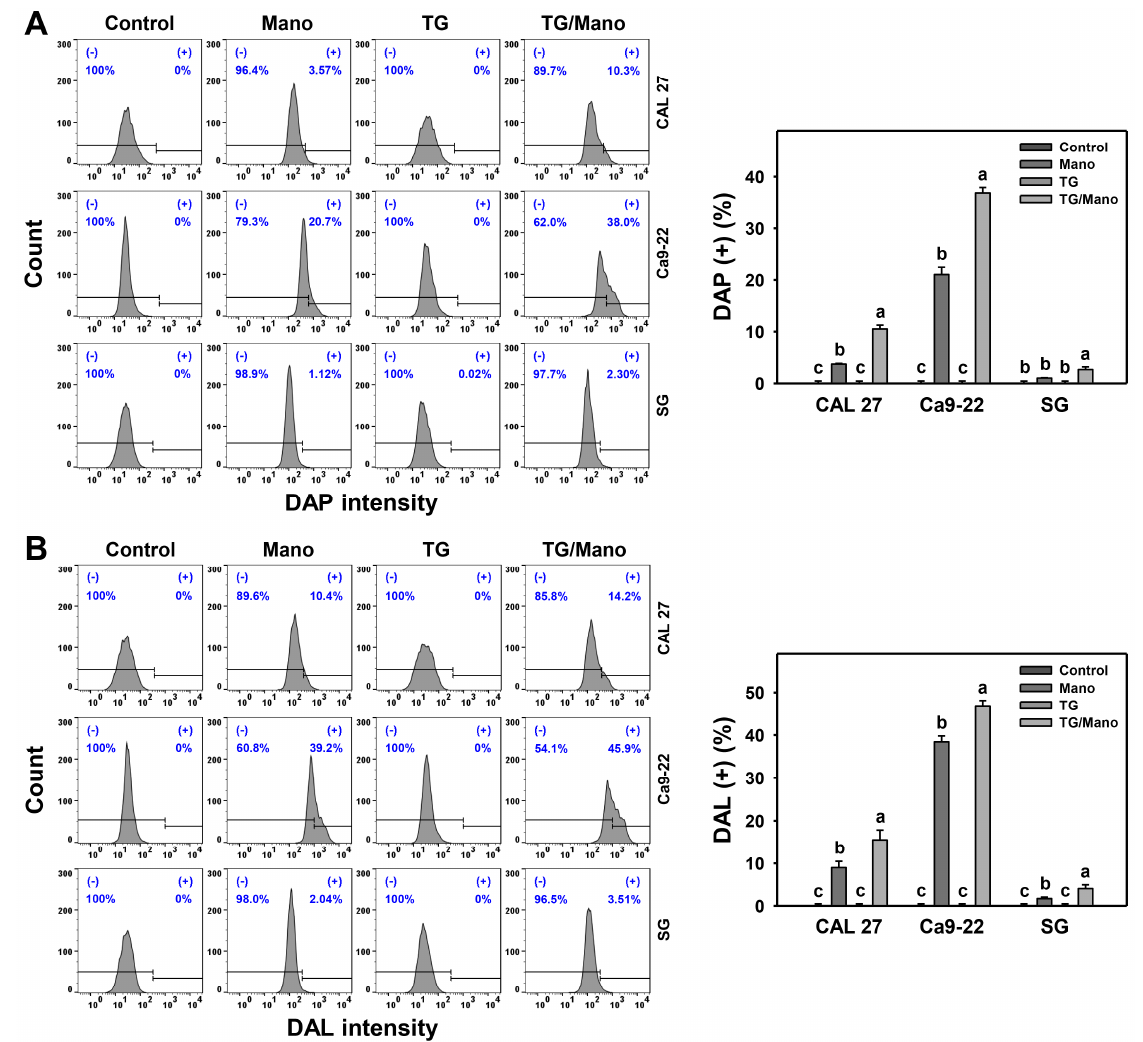
Figure 6. ER stress inducer (TG) enhances the autophagy of manoalide in oral cancer cells. ( A , B ) Autophagy change of TG and/or manoalide was assessed by DAPGreen and DALGreen assay. Cells were co-treated with TG (0.01 µ M) or/and manoalide (10 µ M) for 24 h. Data, means ± SDs ( n = 3). Multiple comparisons were analyzed for the same cell lines. Treatments marked with different notes indicate a significant difference ( p < 0.05 to 0.0001).